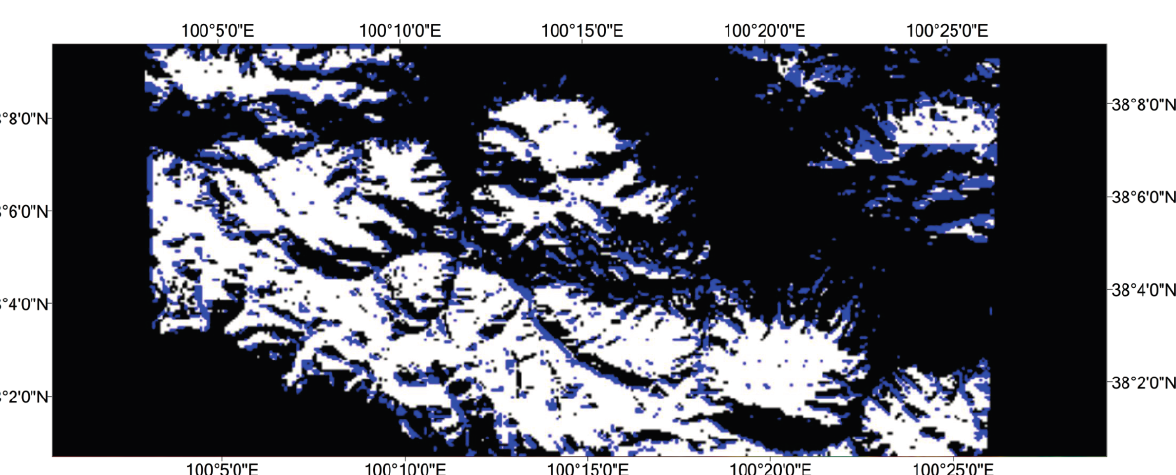
Figure 9. Differences between downscaled snow pixels and 30-m-resolution RS images. Six comparisons are presented. The figure on the left is the downscaled snow map generated for a known SCF, and the figure on the right is the real snow distribution. Snow-covered and snow-free areas are depicted in white and black, respectively.